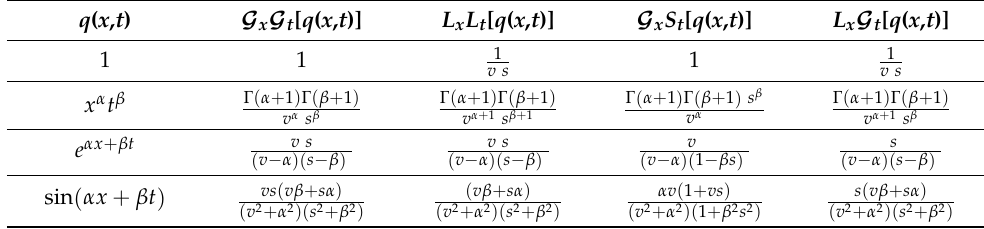
Table 1. Comparisons between DARAT and other